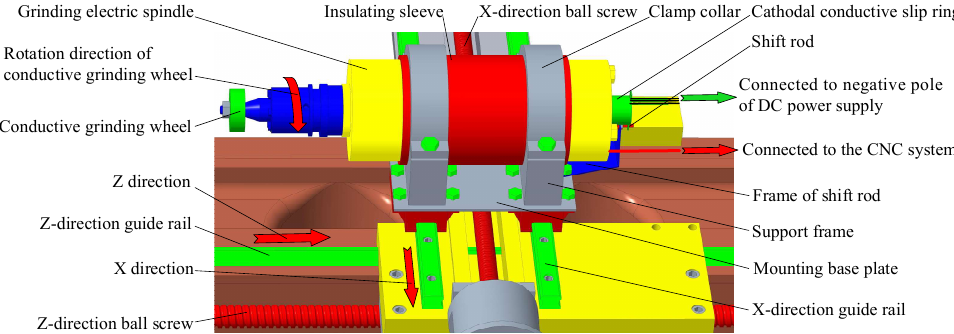
Figure 9. Schematic diagram of the grinding electric spindle mounting and fixing